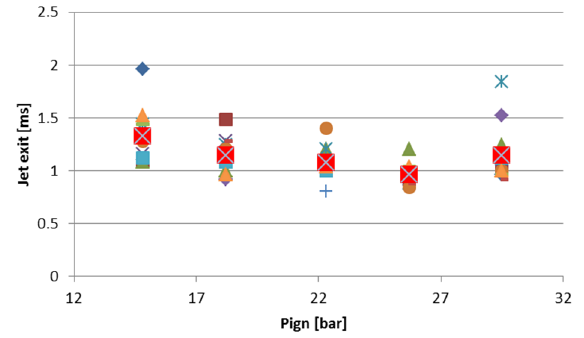
Fig. 2. Time of burning jet emergence into the main chamber for all 12 repetitions per operating point, plotted versus P ign The average trend indicates the combustion in the pre- chamber to be faster with increasing pressure at ignition up to P = 26 bar. This is expected to be the result of the ign combination of increasing reactivity due to the charge tem- perature and in particular better mixing of prechamber fuel with incoming main chamber charge later in the